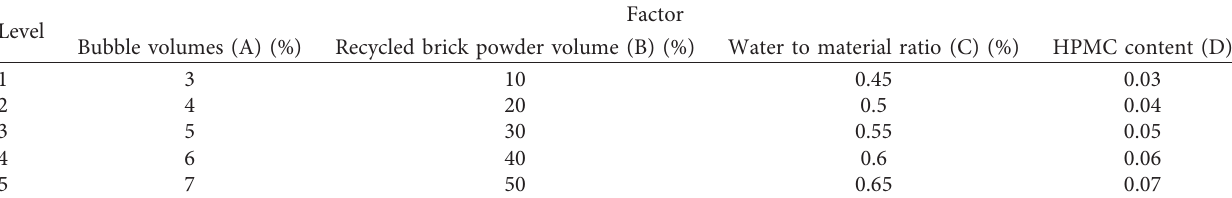
Table 6: Orthogonal test factor level of experimental group.